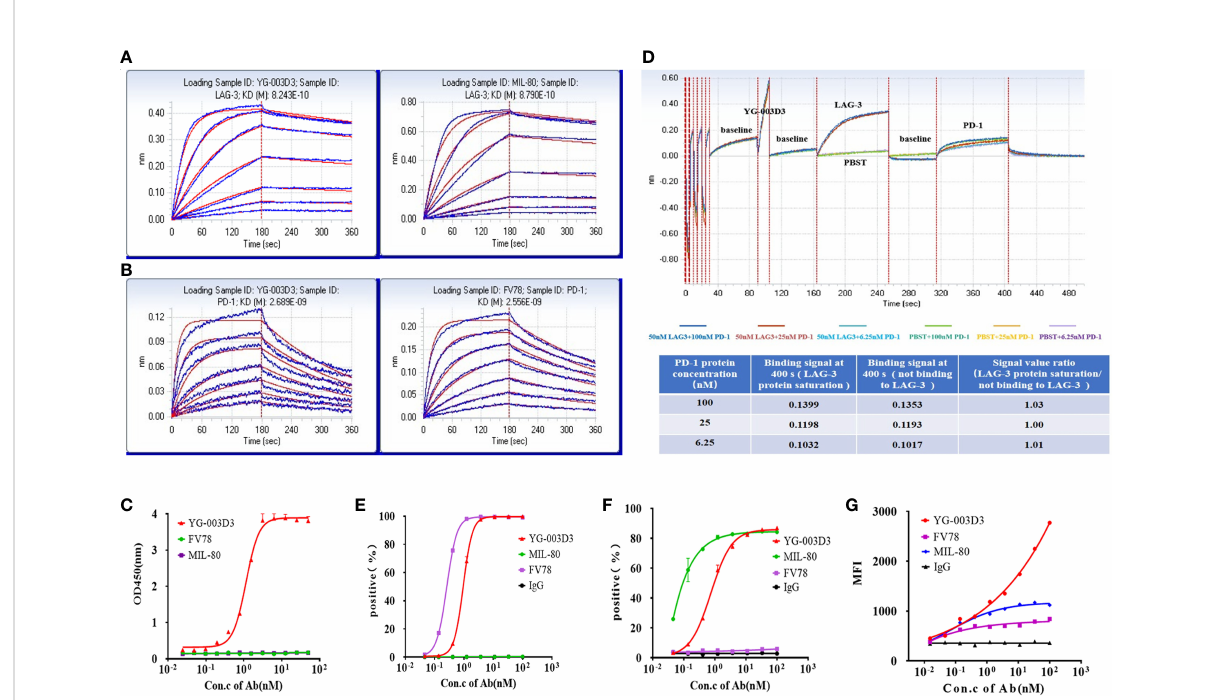
FIGURE 2 The binding activity of YG-003D3 to human PD-1 and LAG-3. (A) BLI Veri fi cation of af fi nity of YG-03D3 or MIL-80 to LAG-3. The af fi nity of YG- 003D3 to LAG-3 was 824.3 pM, which was similar to that of MIL-80 (879.0 pM). (B) BLI Veri fi cation of af fi nity of YG-03D3 or Fv78 to PD-1. The af fi nity of YG-003D3 to PD-1 was 2689.0 pM, which was similar to that of Fv78(2556.0 pM). (C) Double-antigen sandwich ELISA veri fi ed the bispeci fi c antibody could recognize LAG-3 and PD-1 simultaneously. (D) BLI veri fi ed that there was no steric hindrance in the binding of the bispeci fi c antibody to LAG-3 and PD-1 simultaneously. (E) YG-003D3 binds to PD-1-expressing cells in a dose-dependent manner. (F) YG- 003D3 binds to LAG-3-expressing cells in a dose-dependent manner. (G) YG-003D3 binds to activated PBMCs in a dose-dependent